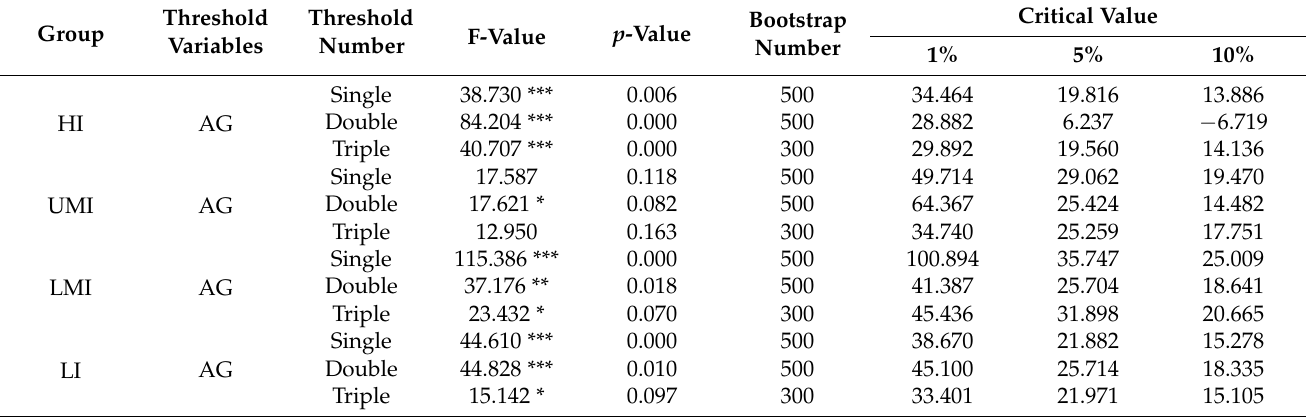
Table 7. Test results of the threshold effect.